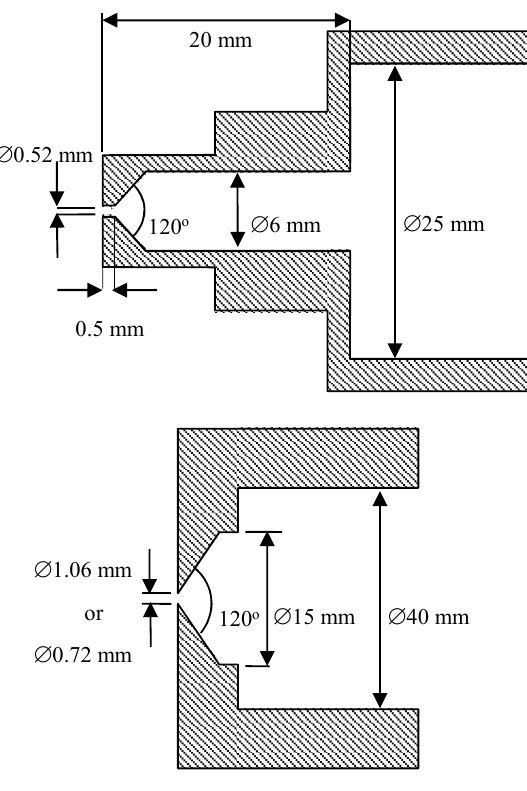
Figure 1. Nozzle scheme.